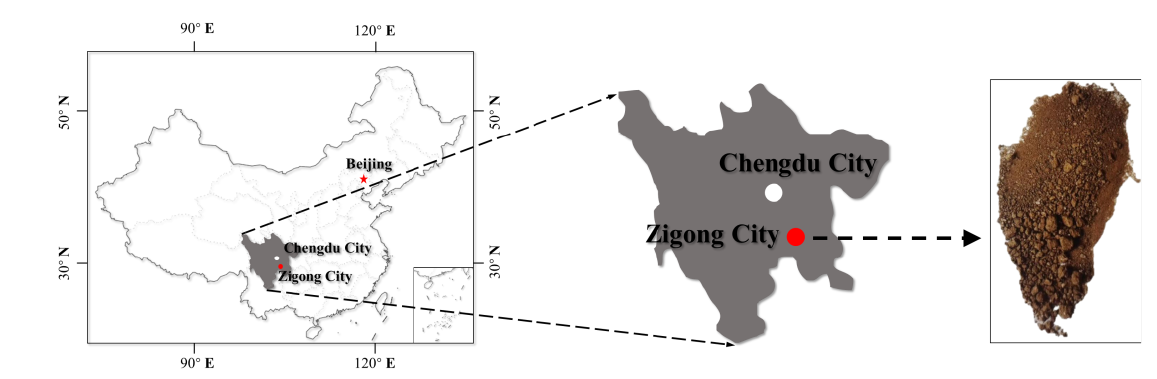
Figure 3. Sampling site for in situ clay.